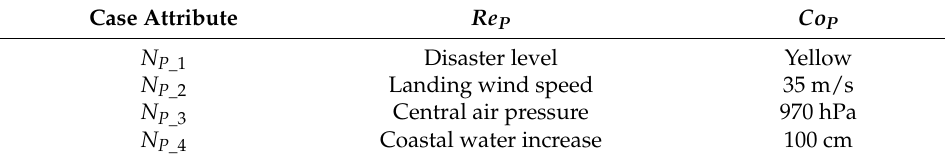
Table 5. Label information V P of storm surge disaster case no. 1.